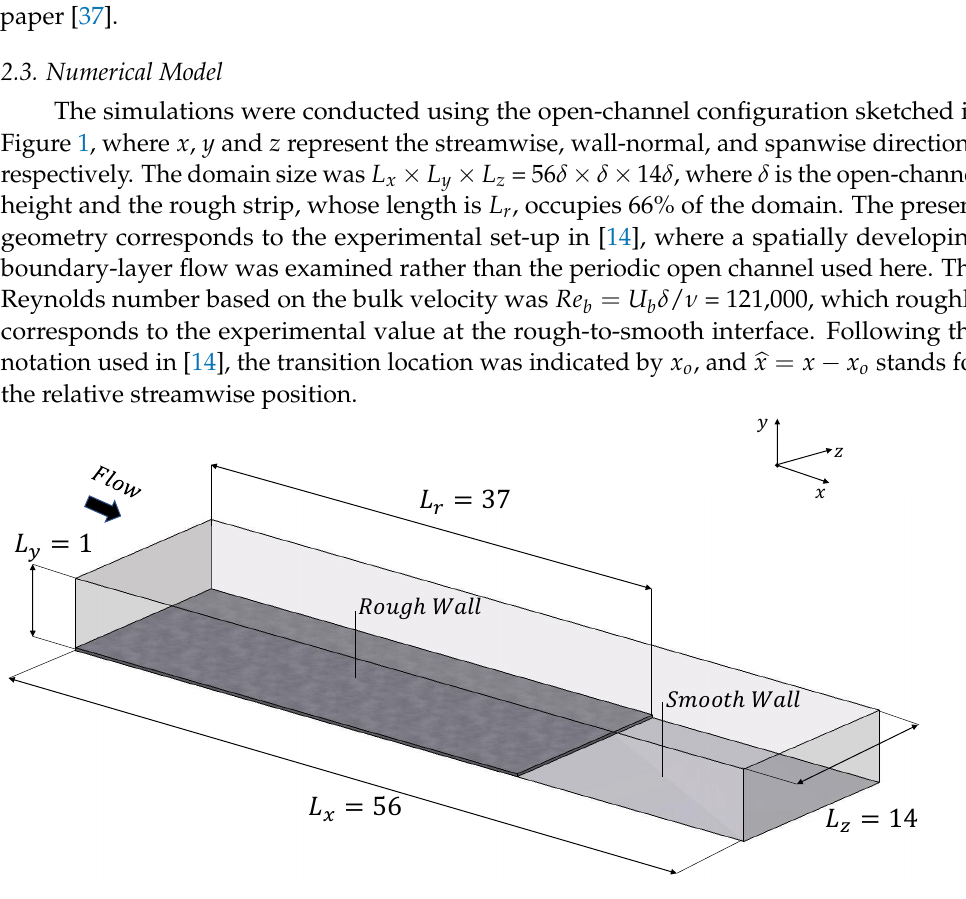
Figure 1. Sketch of the computational domain (not to